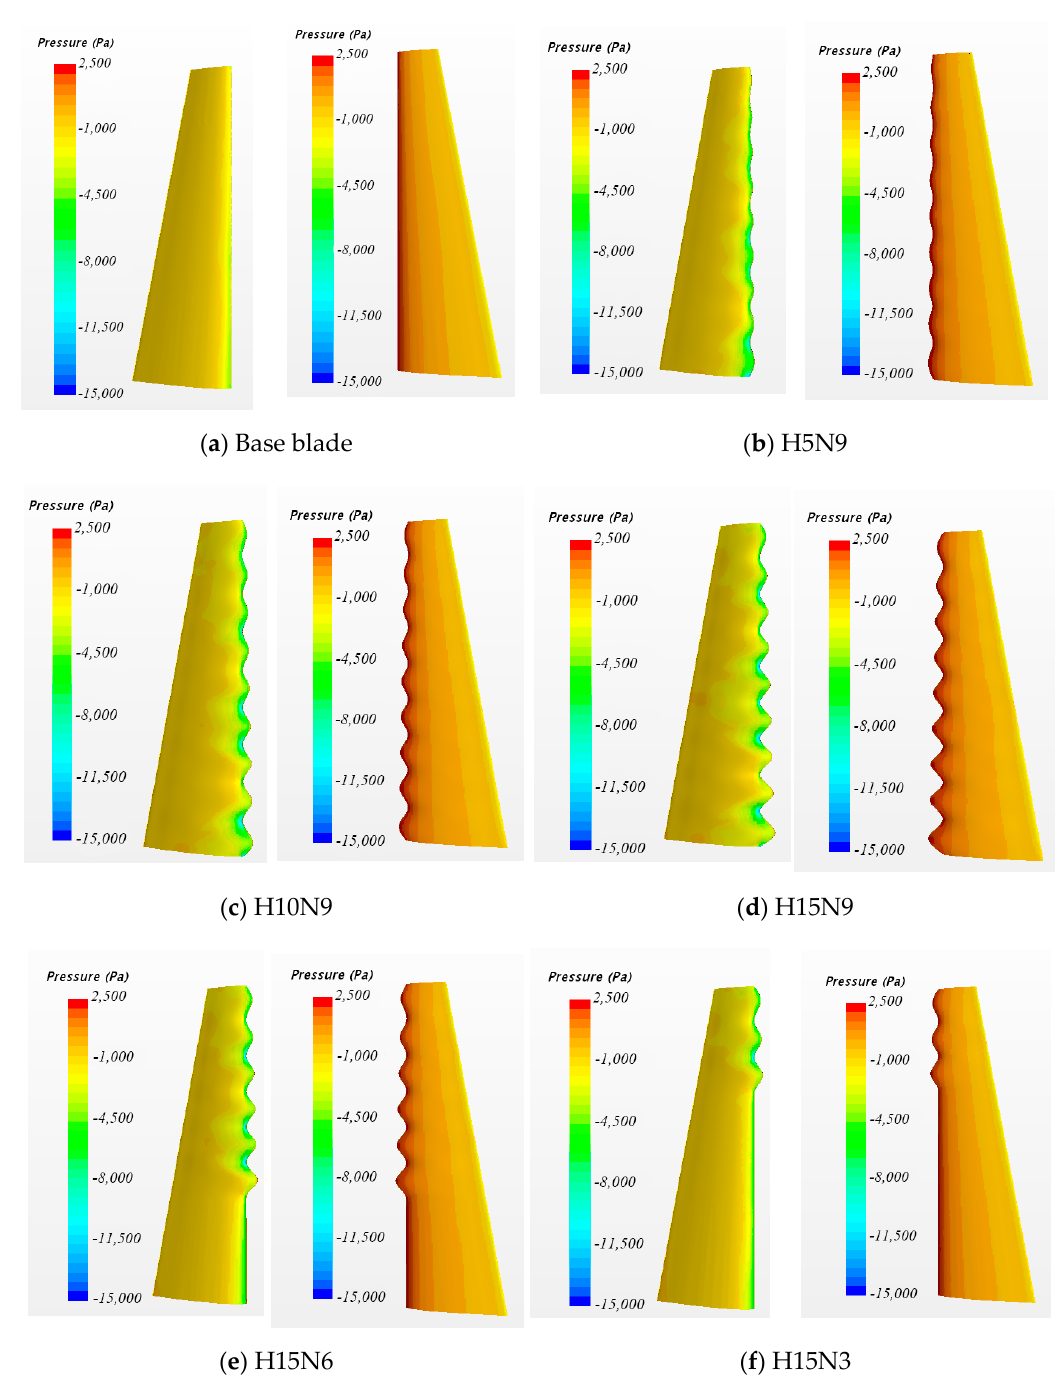
Figure 19. Pressure distributions on the upper (left) and lower (right) surfaces of ( a ) base blade, ( b ) H5N9, ( c ) H10N9, ( d ) H15N9, ( e ) H15N6 and ( f ) H15N3 when attack angle is 24°.